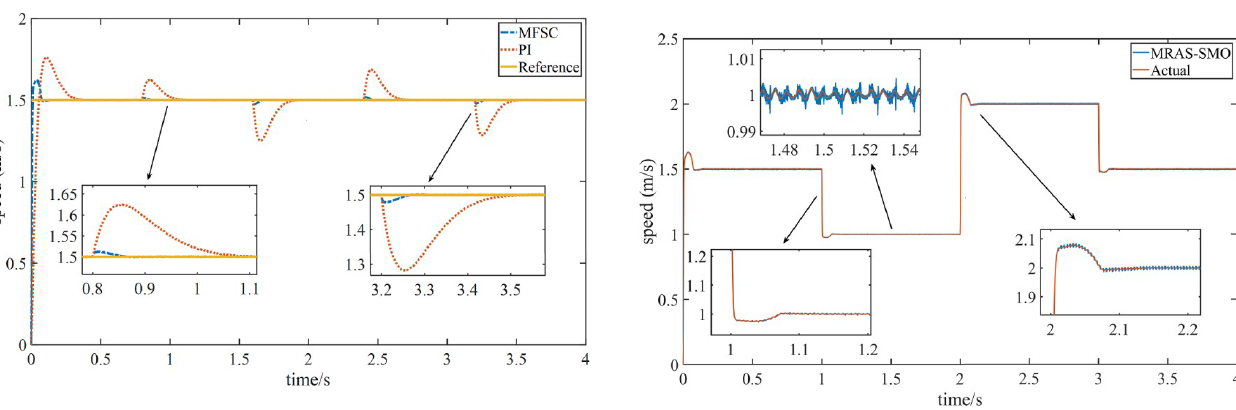
Figure 9. Speed tracking performance test of